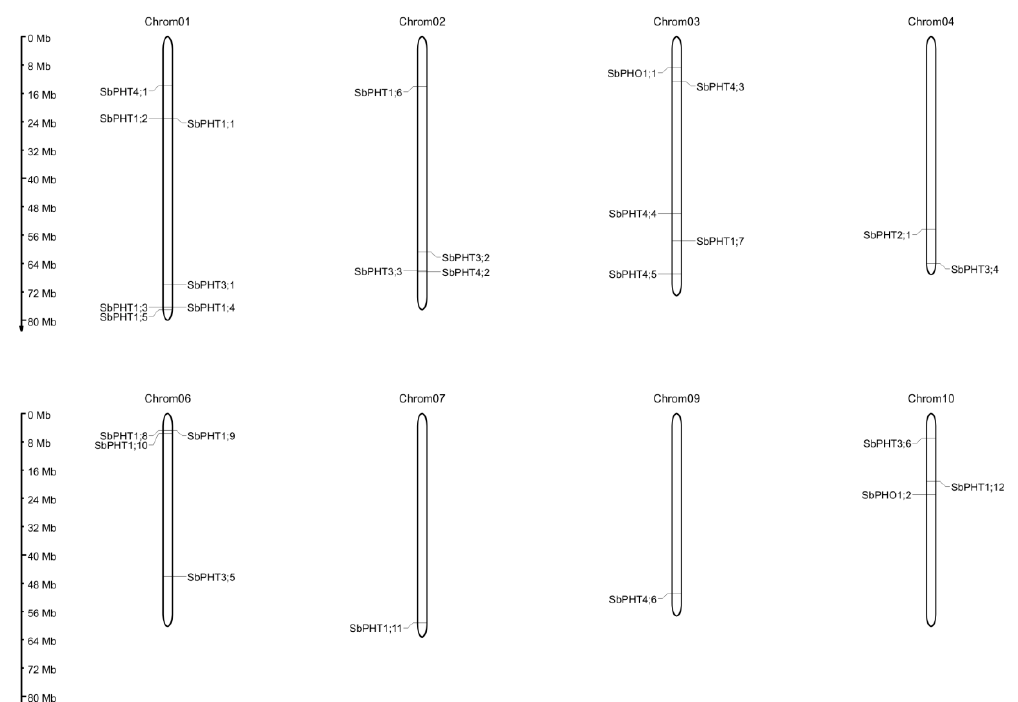
Figure 2. Distribution of PHT genes on the Sorghum chromosomes. The physical locations of the 205